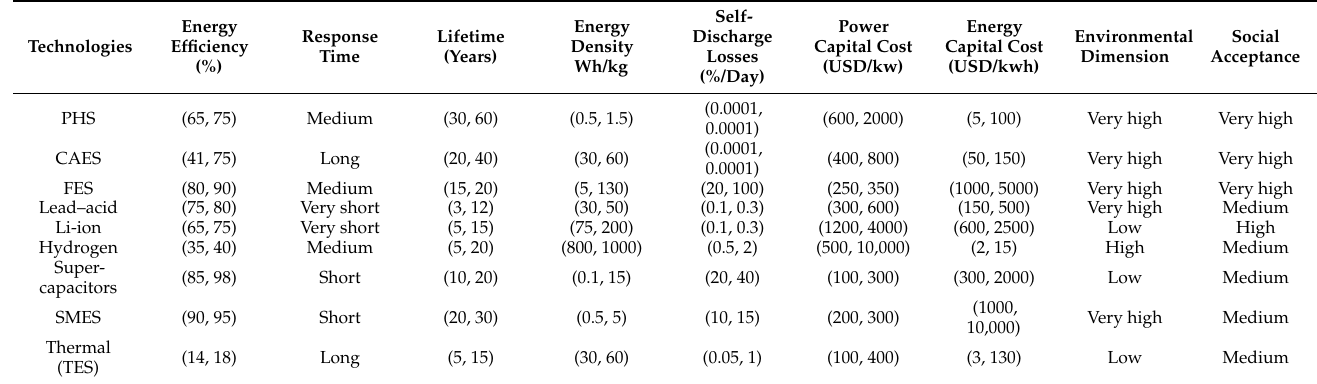
Table A17. Decision basic data of Expert 10.